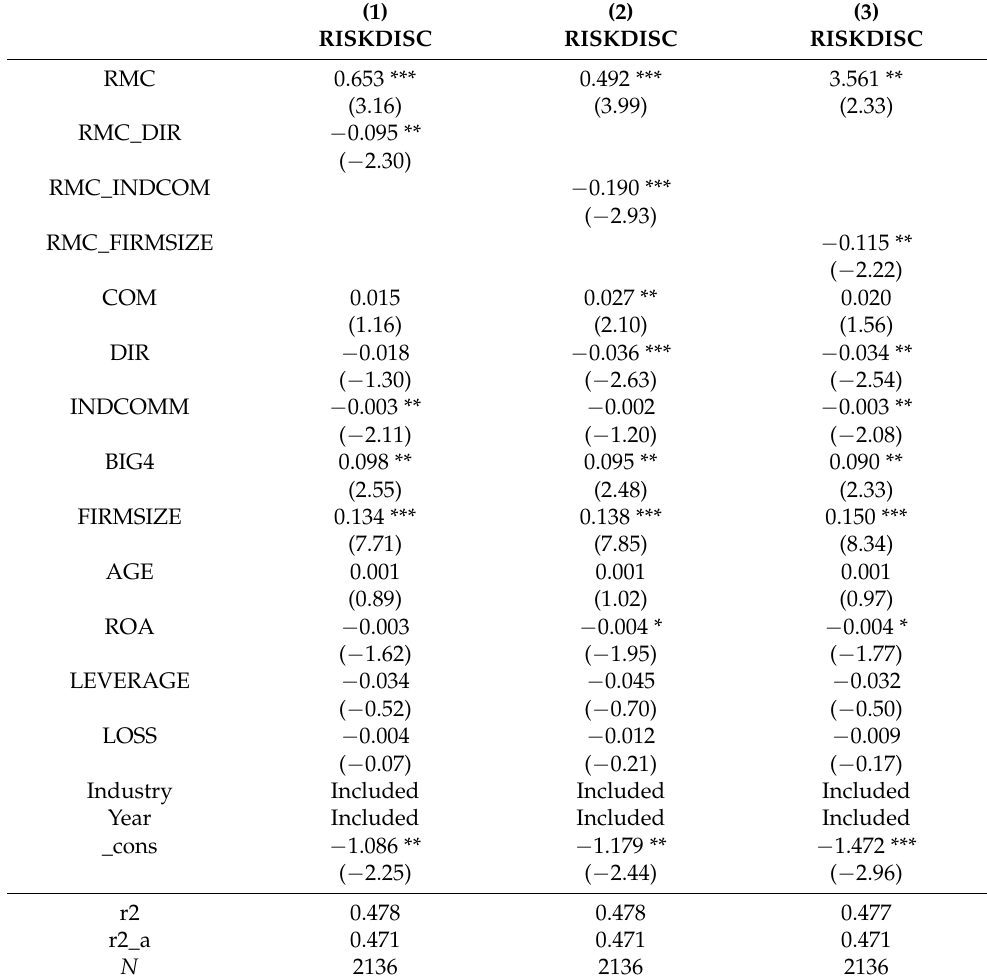
Table 6. Risk management committee, director size, independent director, and firm